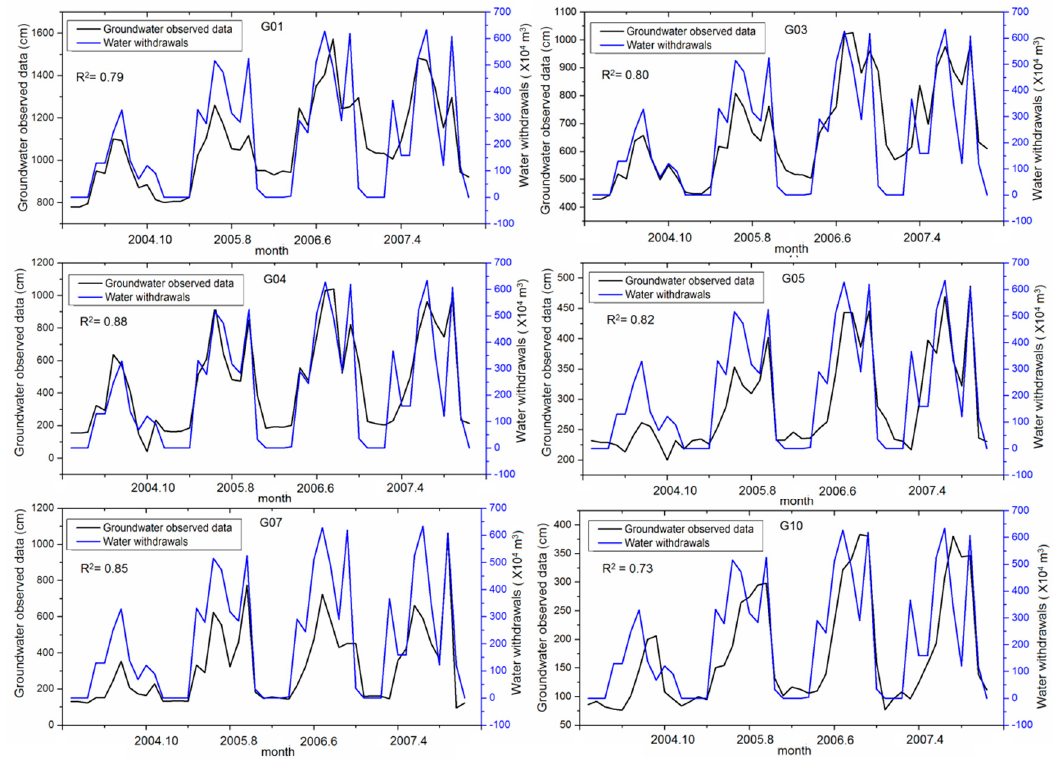
Figure 9. Groundwater (black line) and water withdrawals (blue line) monthly fluctuations of observed wells, 2004–2007.